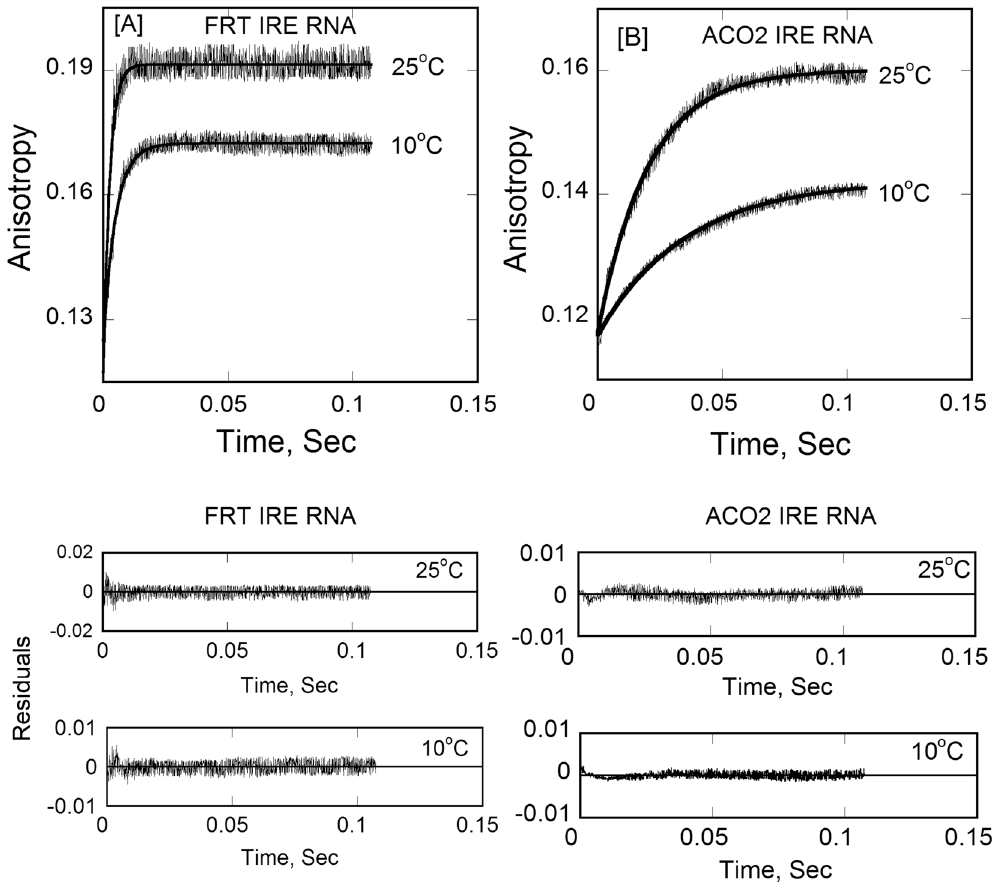
Figure 4. Stopped-flow kinetic measurements of binding of FI FRT IRE-RNA and FI ACO2 IRE-RNA with IRP1 protein. Representative kinetic data show the time-dependent increase in anisotropy after ( A ) FRT IRE-RNA and ( B ) ACO2 IRE-RNA had been mixed with IRP1 at temperature 25 °C and 10 °C. FRT and ACO2 IRE-RNA concentrations was 50 nM (final) and the IRP1 concentration was 1 µ M (final). The solid line represents the fitted curve drawn through the data points was fit by assuming a single-exponential process. Residuals for the exponential fits are shown in the bottom panels. The experimental conditions are described in Experimental Procedures.